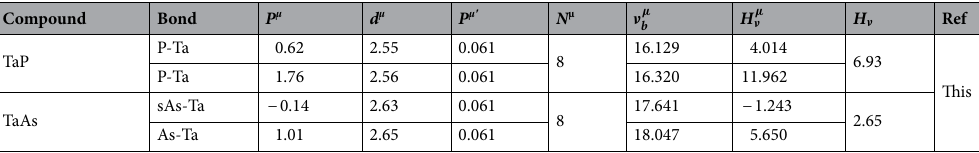
µ H µ ν (GPa) and b (Å 3 ), hardness of µ -type bond